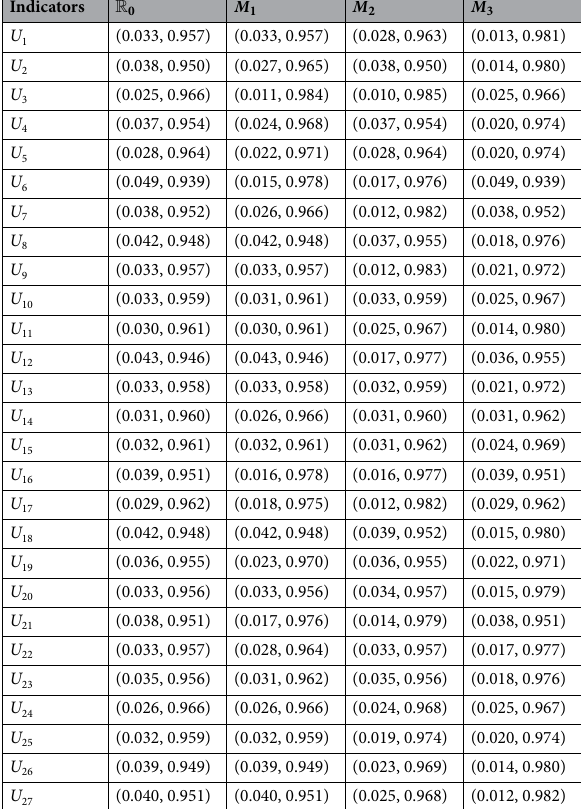
Table 12. The WNA-IFDM for SIBOs